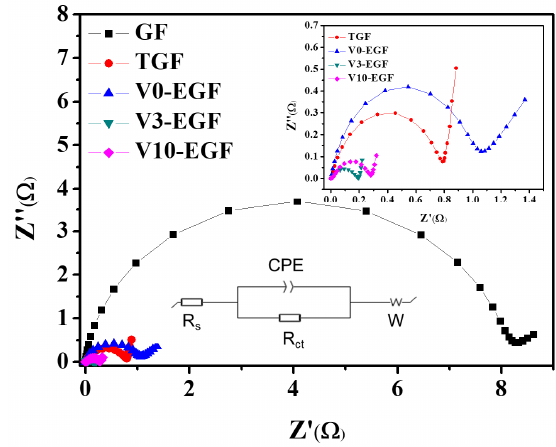
Figure 7. Nyquist plot of GFs at the polarization potential of 0.85 V.